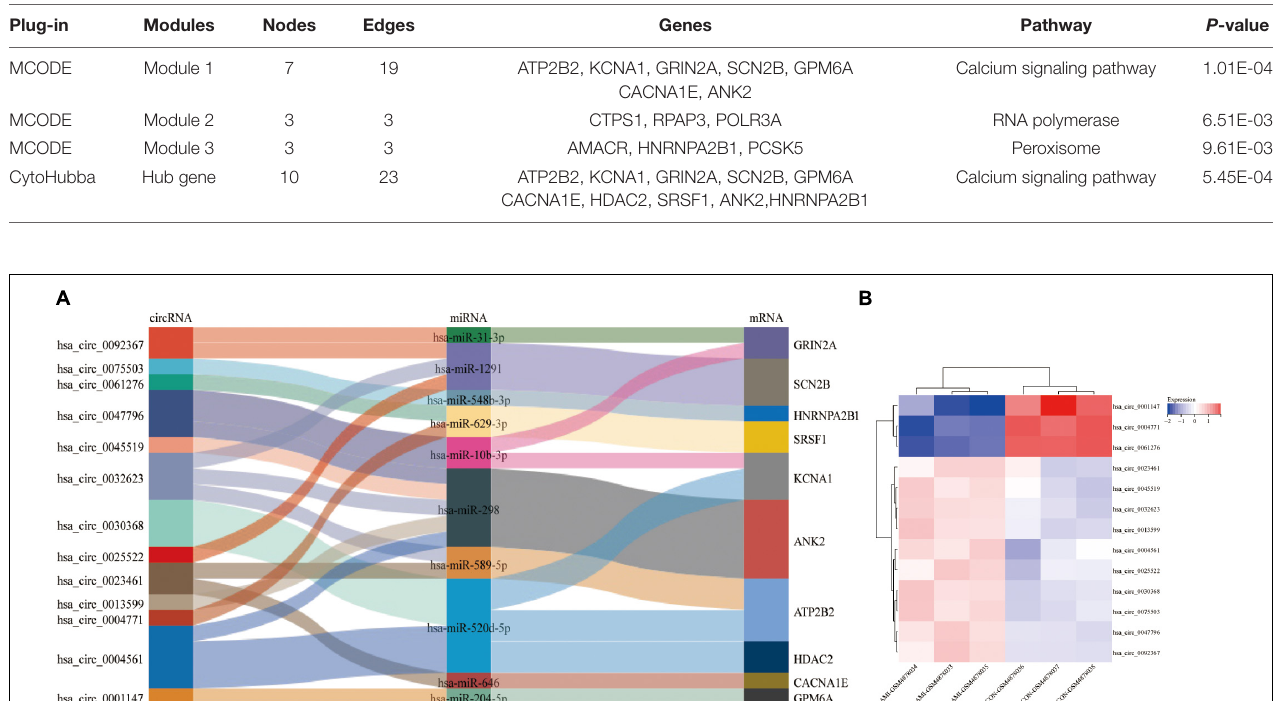
TABLE 4 | The top three significant modules and hub genes in the PPI network.